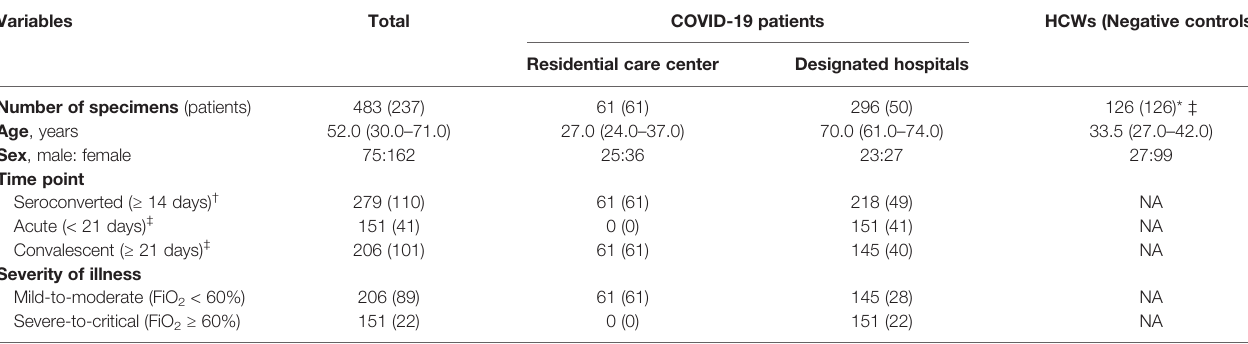
TABLE 1 | Characteristics of the study population and the specimens. Variables